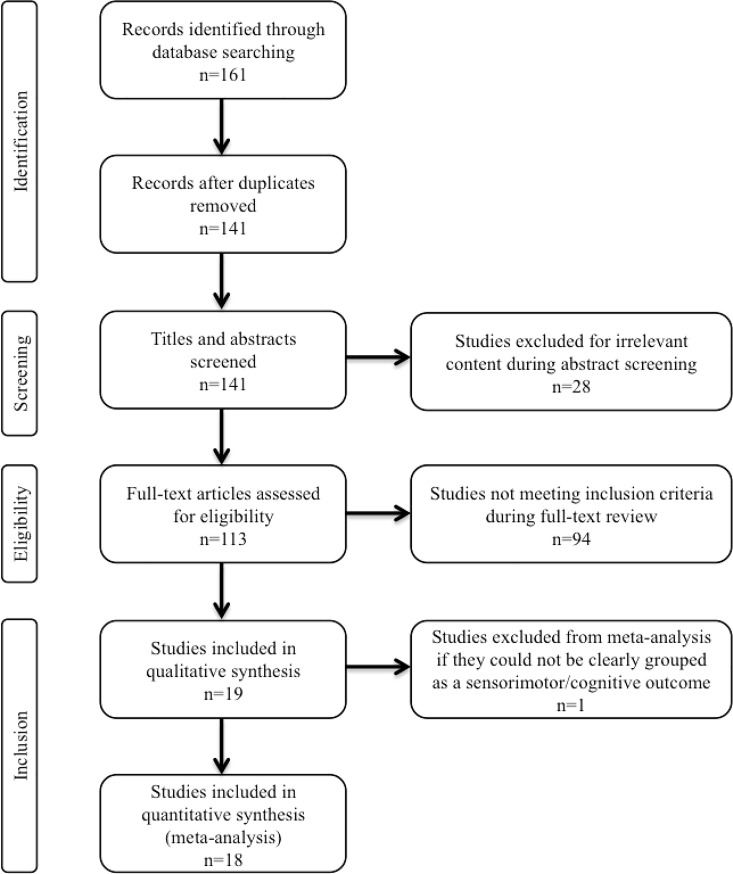
Flow diagram demonstrating study selection process.